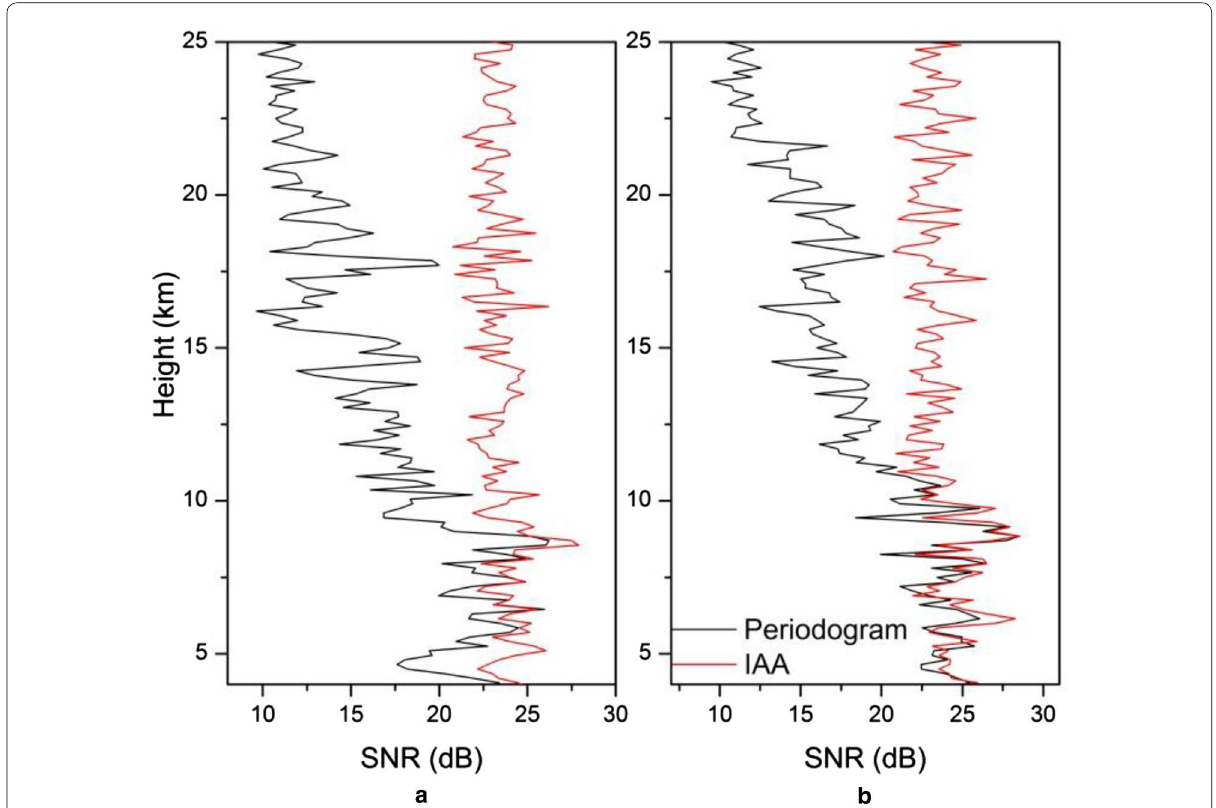
Fig. 4 Height profiles of SNR estimated using periodogram and IAA. a East beam; b south beam for data collected on February 9, 2015